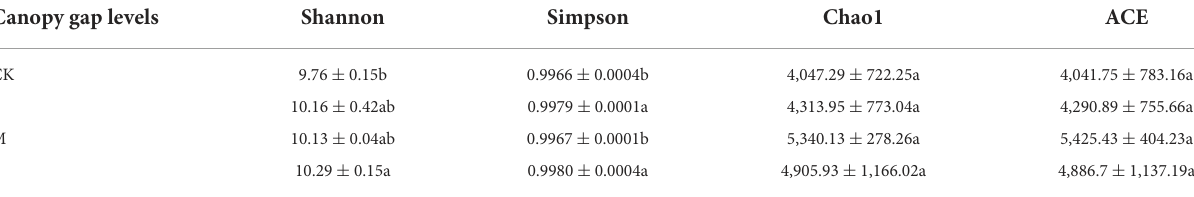
TABLE 2 Bacterial diversity of different canopy gap levels.